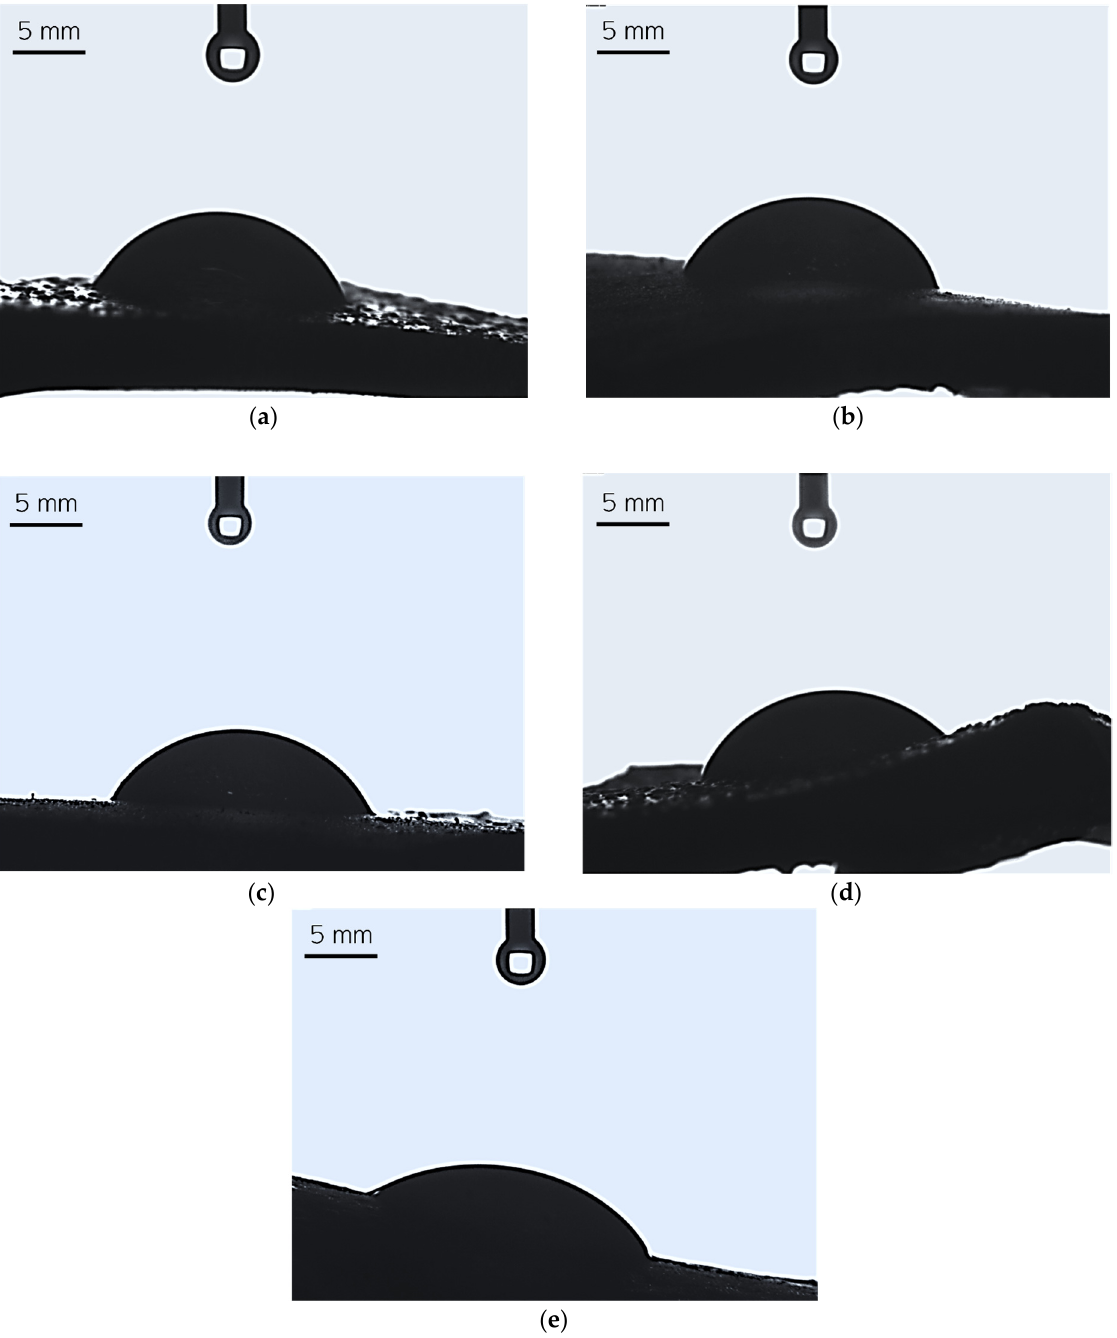
Figure 8. Images showing the wettability of sample 0.025/Photo ( a ), 0.075/Photo ( b ), 0.100/Photo ( c ), 0.125/Photo ( d ), and 0.150/Photo ( e ). Table 4. Parameters determined during the wettability analysis (given as a mean value ± standard deviation (SD).